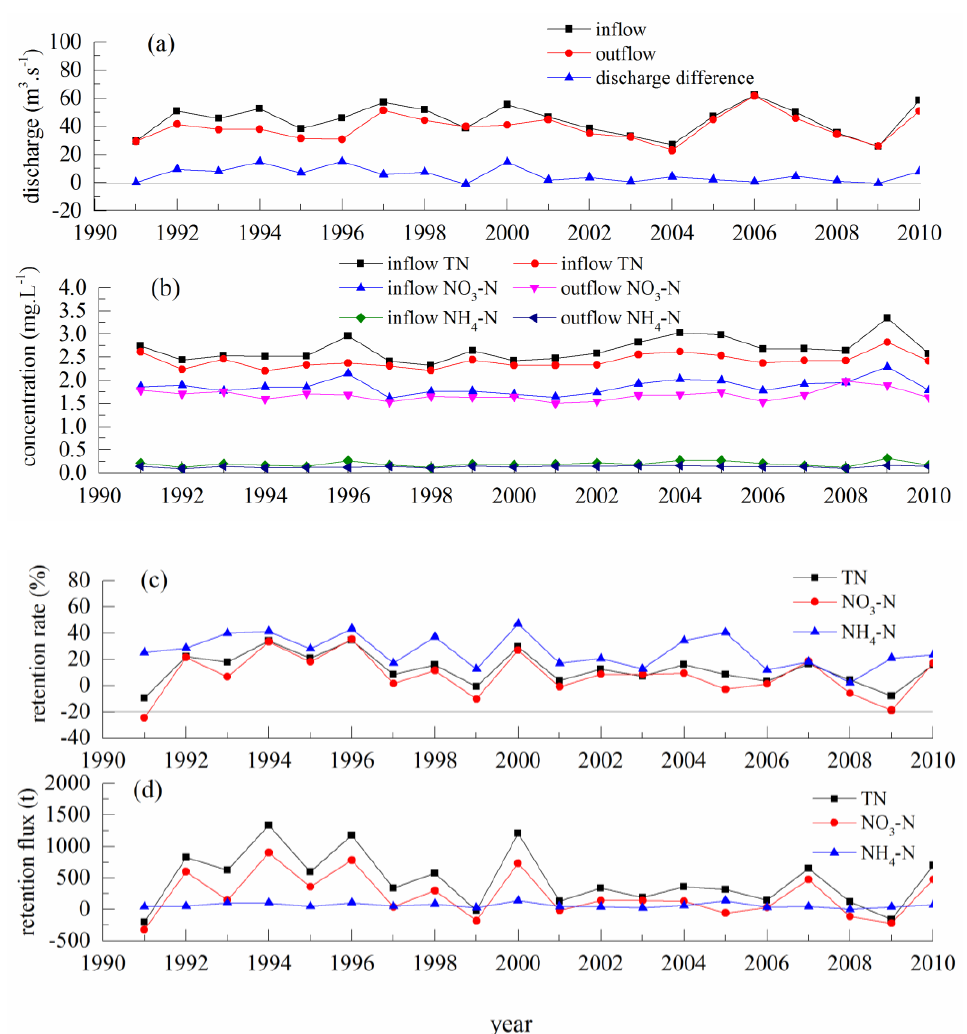
Figure 3. Annual variation of hydrological condition and nitrogen retention e ff ects in Shanmei Reservoir. ( a ) Discharge of inflow and outflow; ( b ) nitrogen concentration of inflow and outflow; ( c ) retention rates of TN, NO 3 -N, and NH 4 -N; ( d ) retention flux of TN, NO 3 -N, and NH 4 -N.